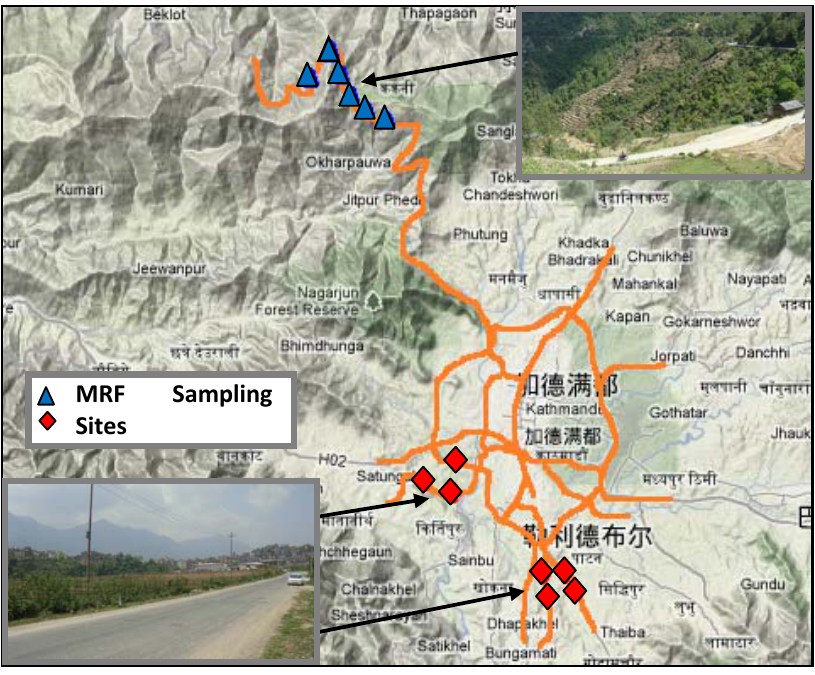
Figure 1. Sampling sites around Kathmandu,